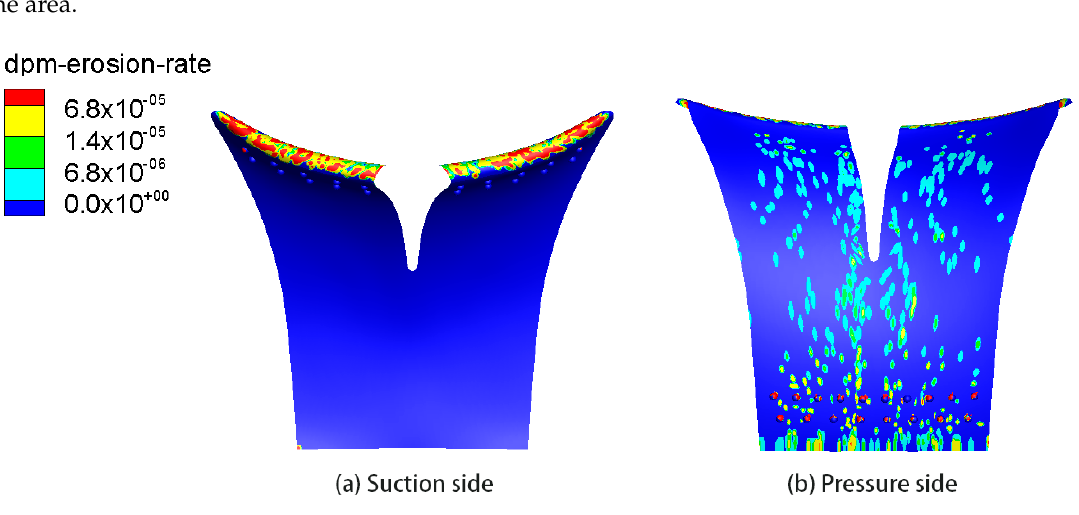
Figure 20. Silt erosion on blade surface with bionic convex domes (units: µ m/s, silt concentration: 2.0 kg/m 3 ).